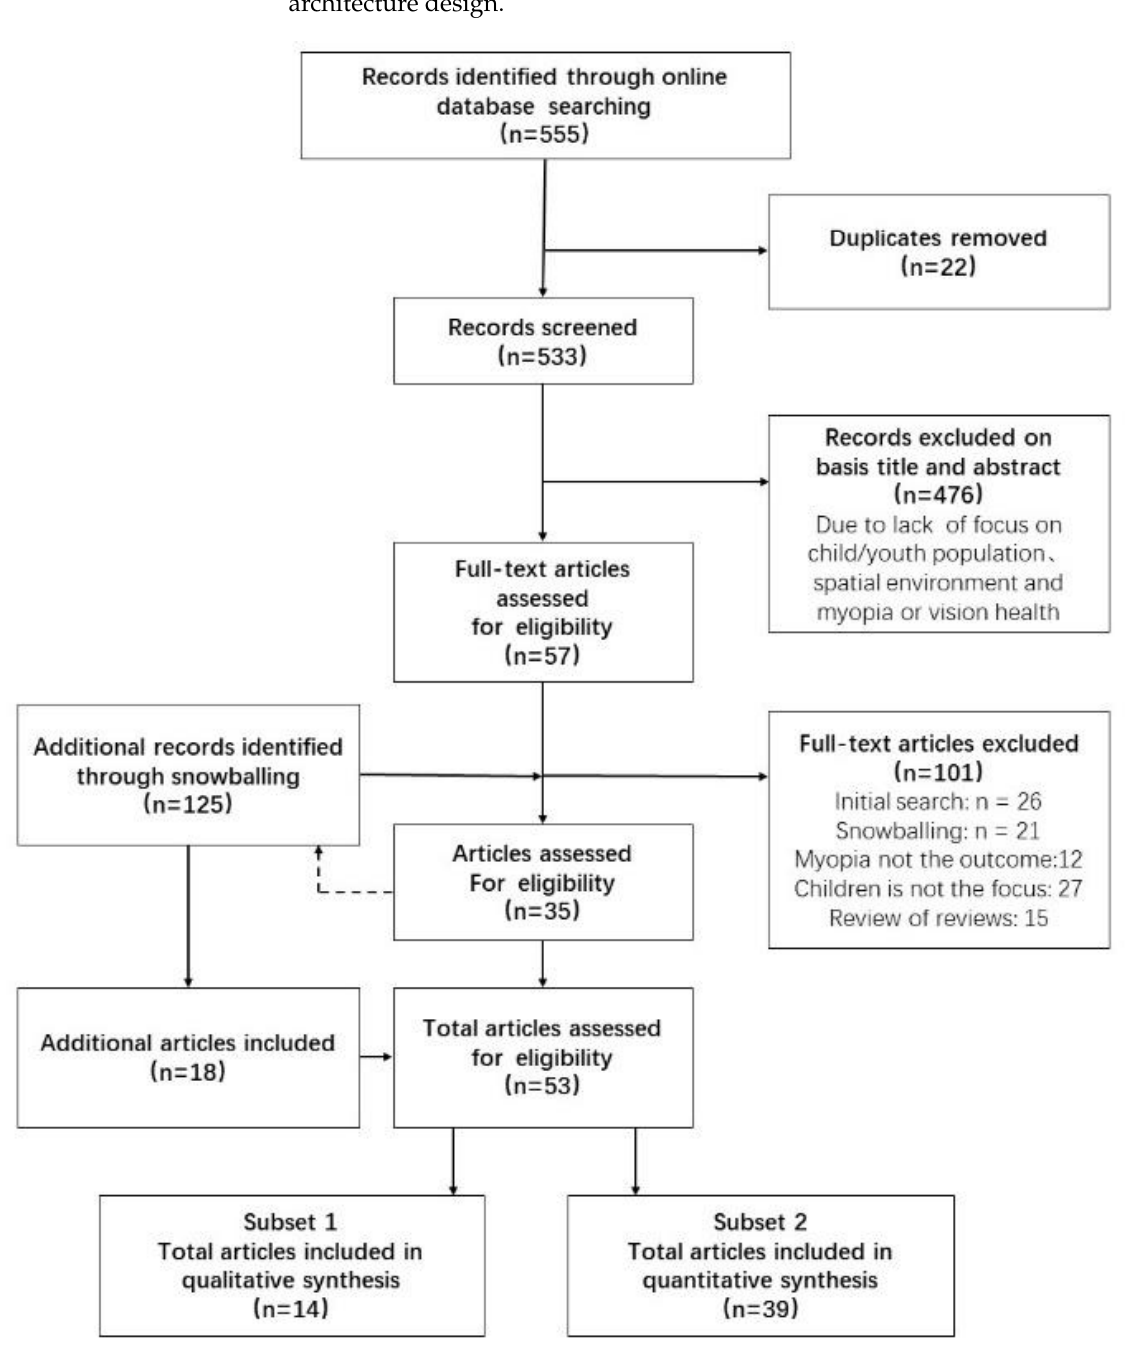
Figure 1. Flowchart: identification and selection of review papers for inclusion in the review. Note: Figure adapted from Libera [12].